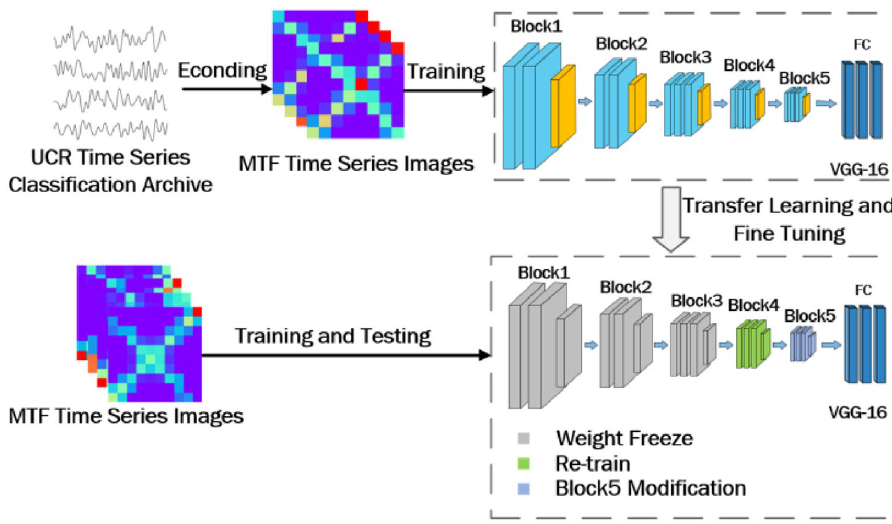
Figure 9. VGG-16 neural network model structure fine-tuning modification picture.